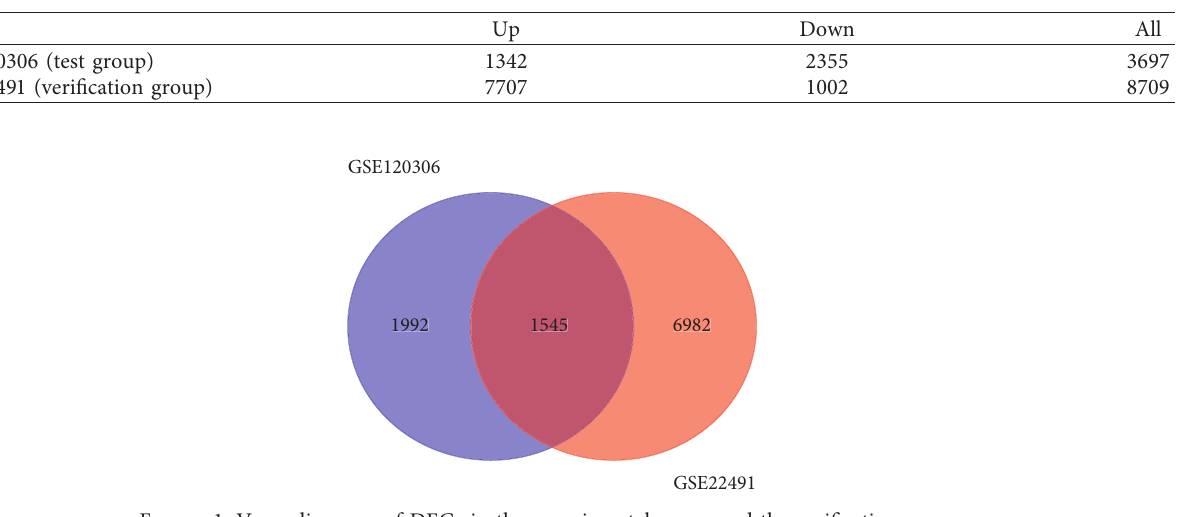
Table 1: Statistics of DEGs.